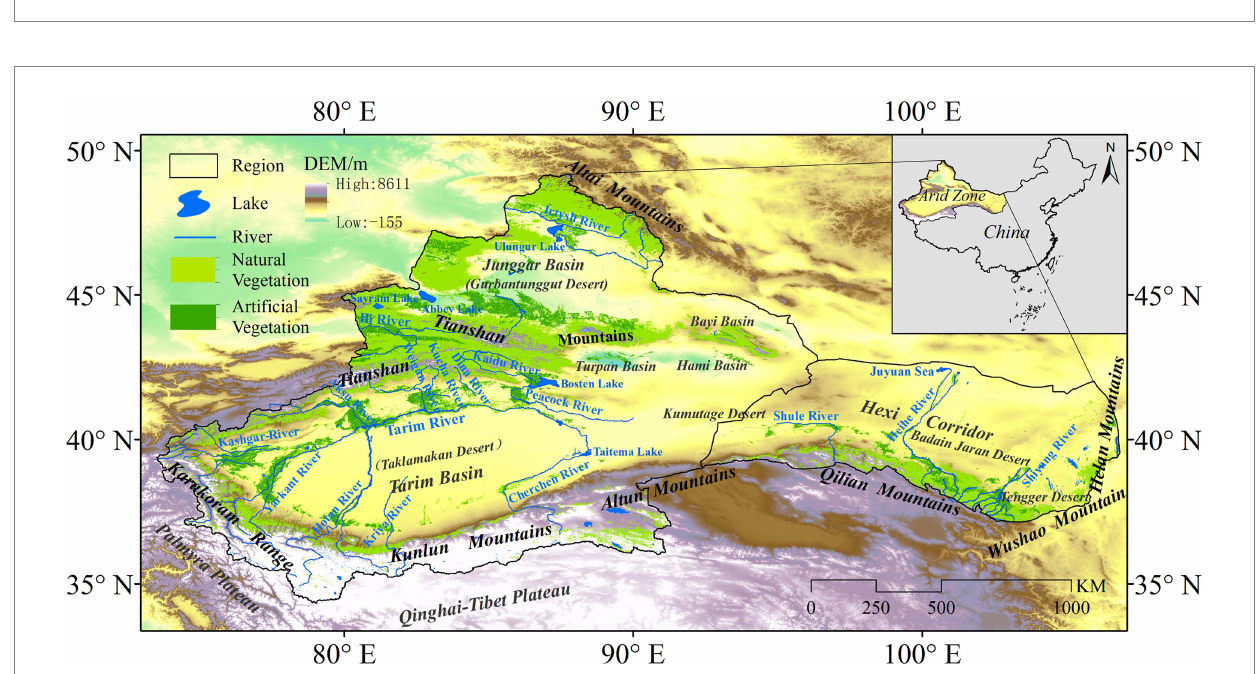
FIGURE 2 Study area. NO.: GS (2019)1822. ARV covered about 6.5% of the study area and NAV covered about